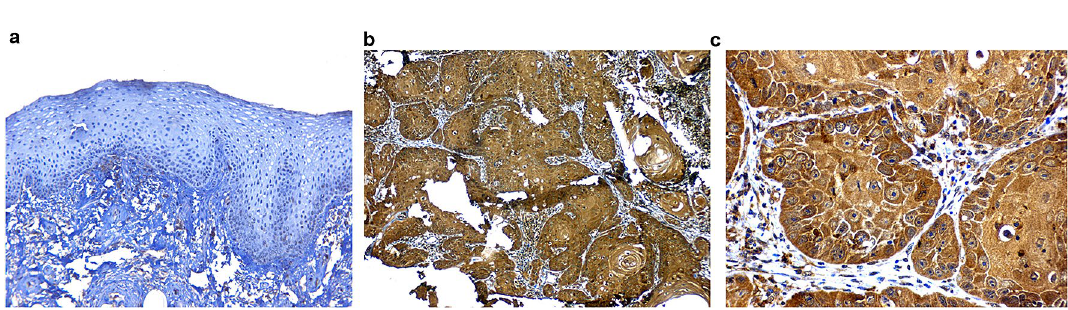
Figure 5. Immunoexpression of MMP9 ( a ). Normal mucosa showing minimum stain for MMP9 ( b ). WDSCC showing intense MMP9 stain 10X ( c ). WDSCC showing intense MMP9 stain